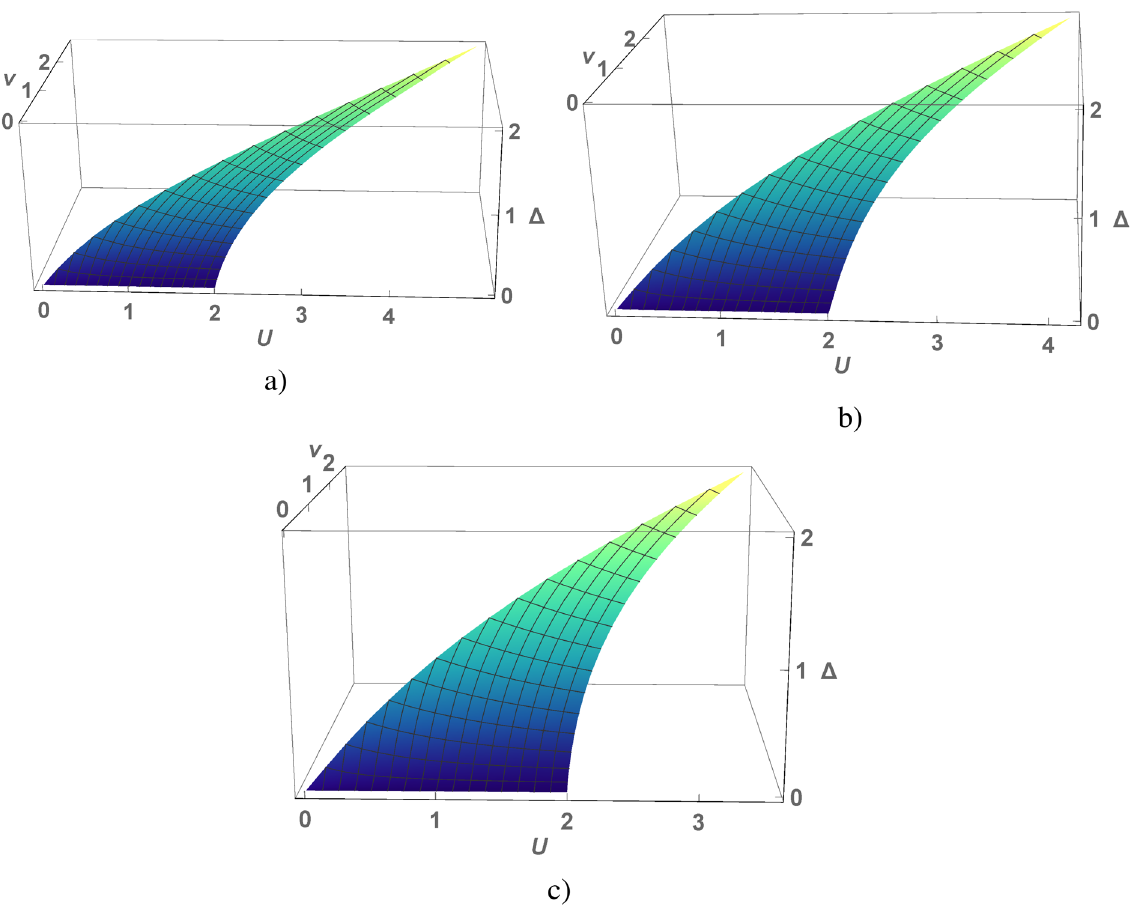
and cubic ( c ) lattices under the condition v < 2 √ 2 (cid:31) .